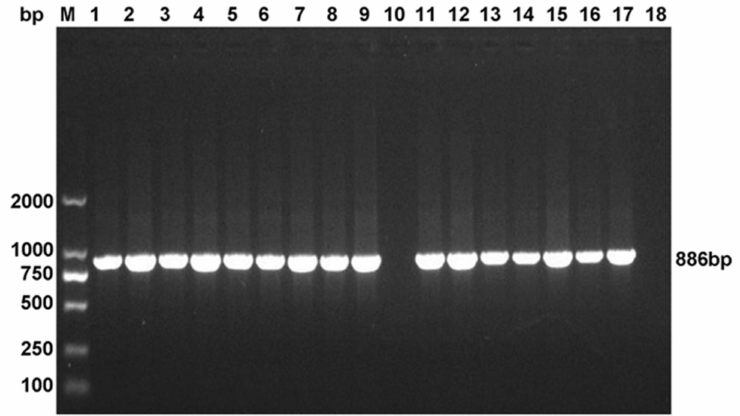
Figure 1. Detection of 16S rDNA gene in isolates by PCR. M: DNA molecular weight standard. 1–16: PCR of 16S rDNA gene in bacteria isolates; 17: positive control; 18: negative control.